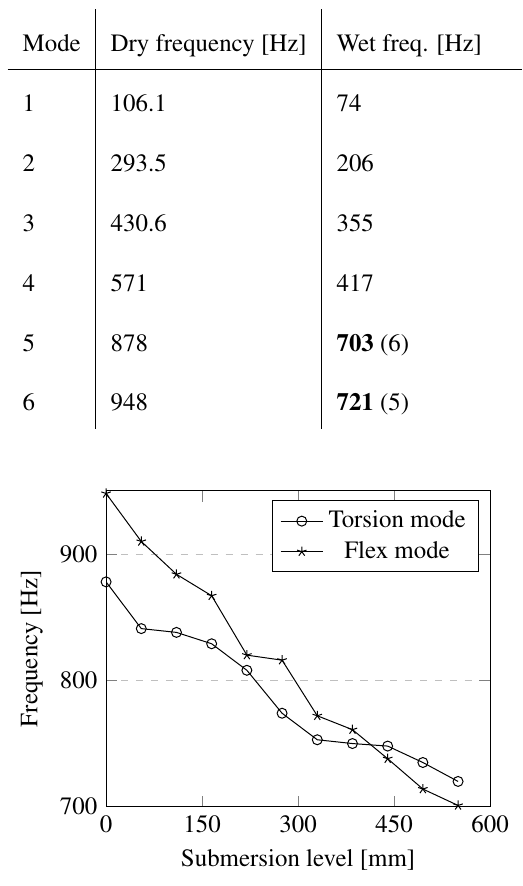
Fig. 2. Second torsion and fourth bending mode during immer- sion, experimental data